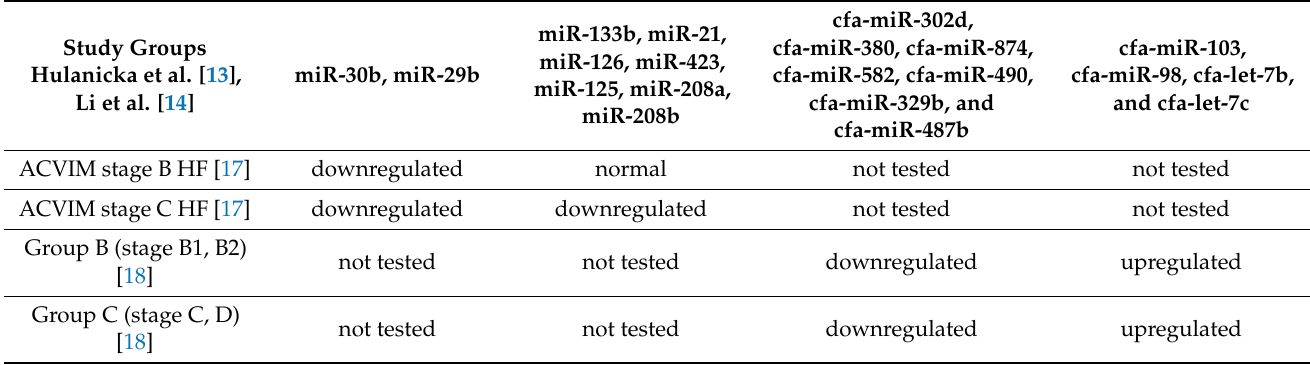
Table 1. The main results from preclinical studies testing miRNAs are tabulated. Stages B and C from Hulanicka et al. [17] respectively stand for asymptomatic and mild/moderate heart failure. Group B and C from Li et al. [18] represent myxomatous mitral valve disease (MMVD) stages B1 and B2 for group B, stages C and D for group C. ACVIM; American College of Veterinary Internal Medicine, mi-R: microRNA.